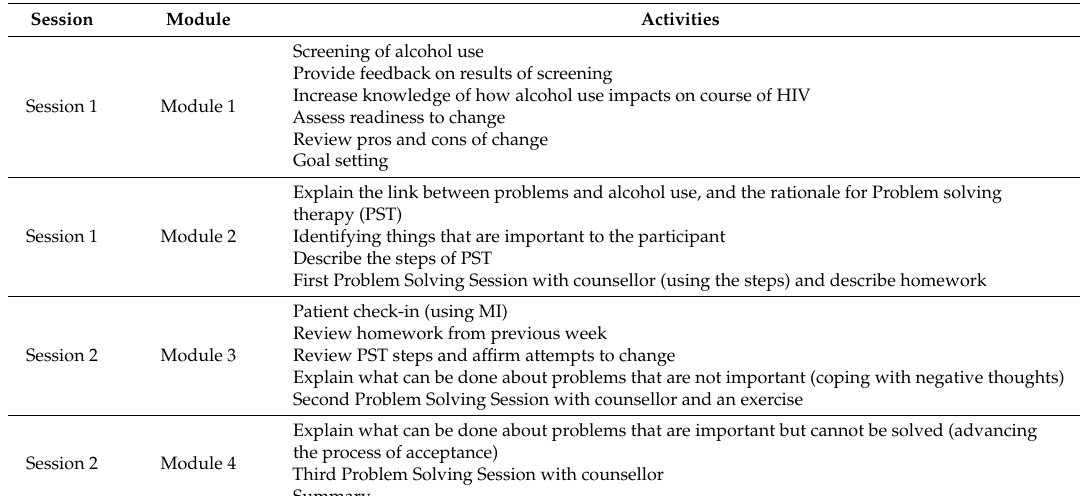
Table 1. Overview of intervention sessions and